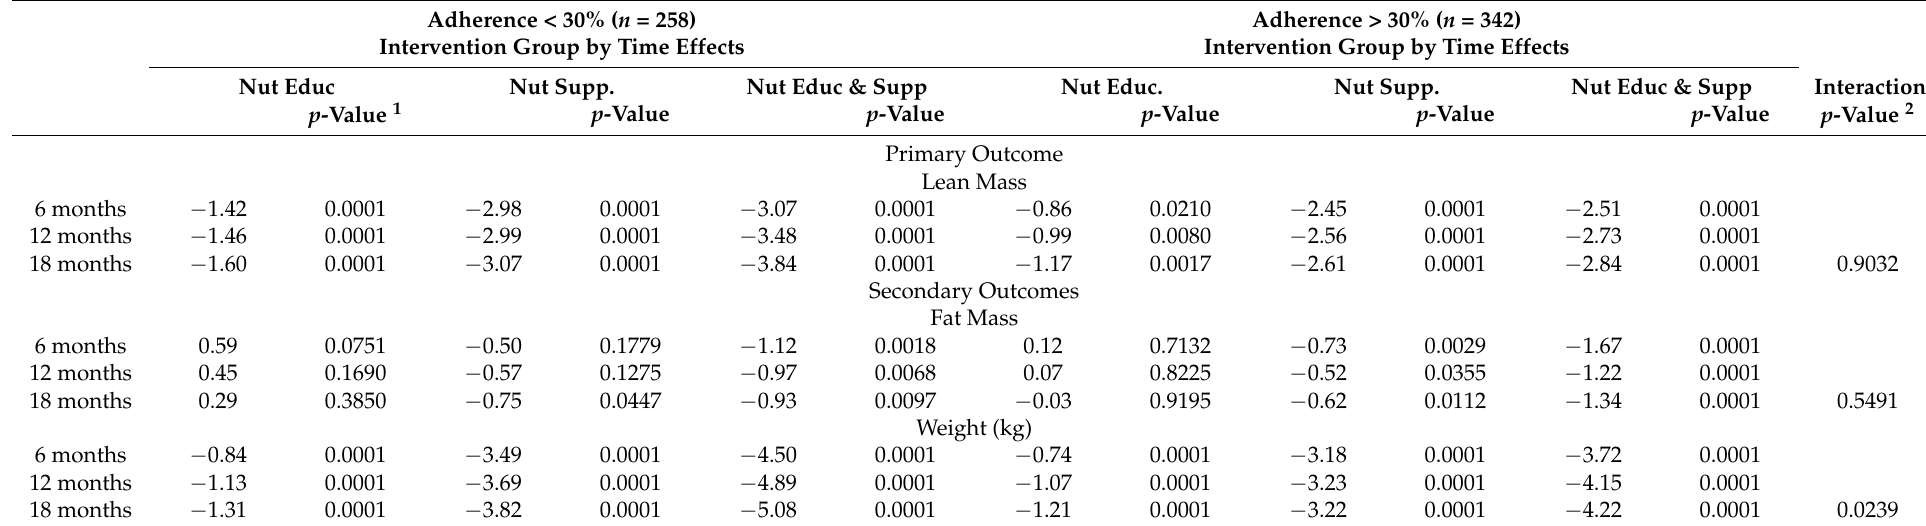
Table 4. Mixed Model Effects of Interventions by